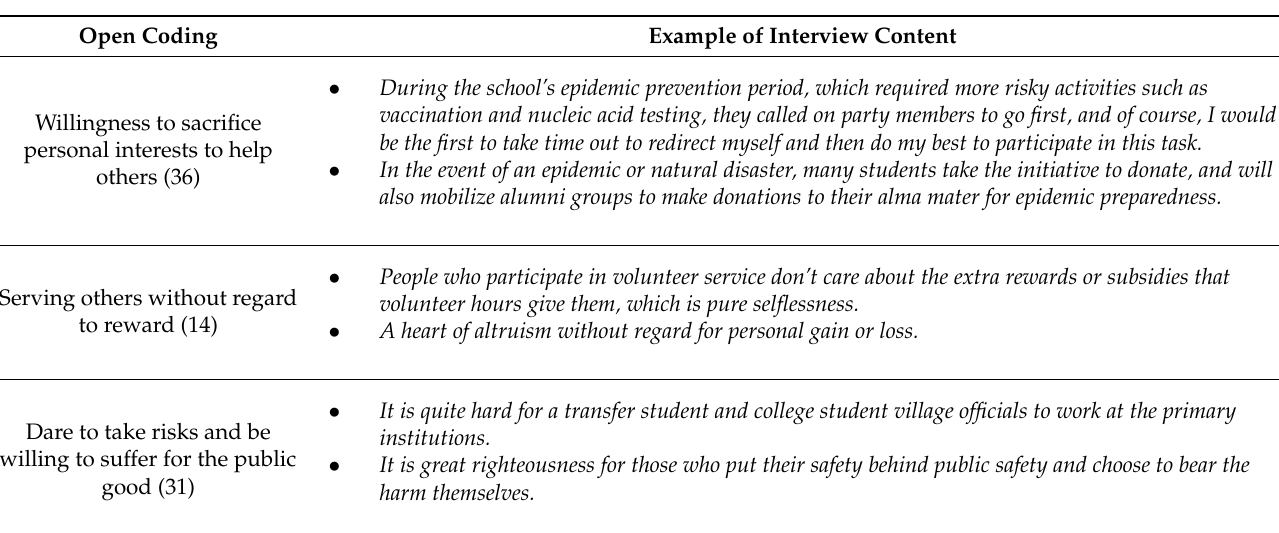
Table 5. Material information of the “self-sacrifice” sub-node of axial